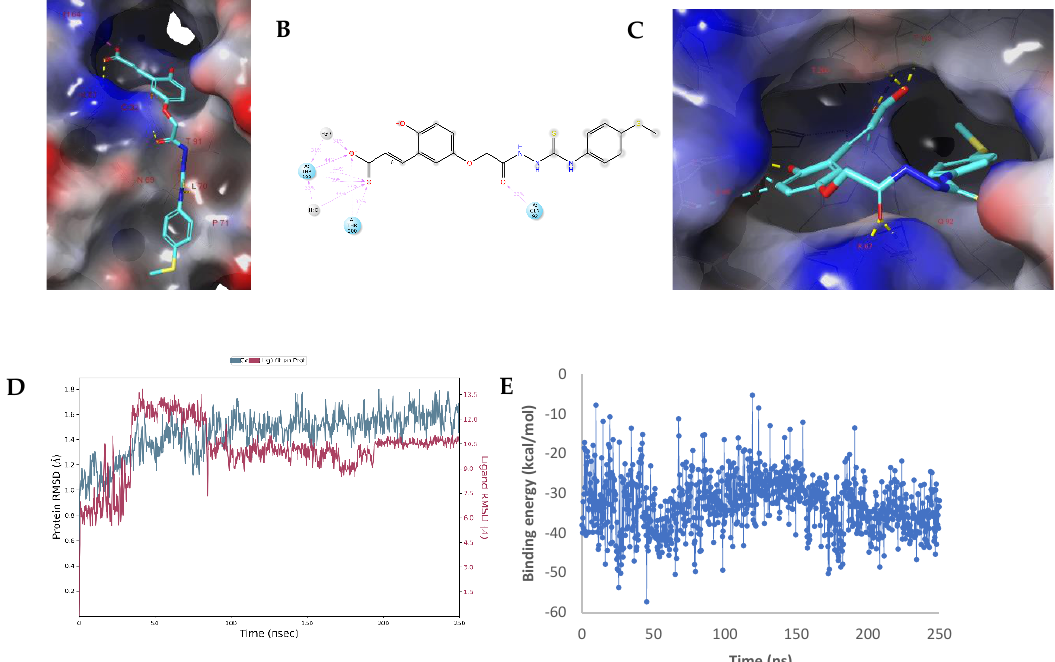
Figure 4. Molecular modelling results of the hCA XII– 22a-( E )-open interaction. ( A ) Docked pose of 22a-( E )-open . ( B ) The ligand–protein binding interactions observed for 30% or more of the duration of the unrestricted MD simulation. ( C ) Ligand pose after a 250 MD simulation. ( D ) RMSD value of the protein C α -atoms and the ligand heavy atoms. ( E ) Binding energy. In the 2D plots, anionic residues are indicated in red, cationic residues are indicated in purple, hydrophobic residues and surfaces are indicated in green and hydrophilic residues and surfaces are indicated in light blue. Hydrogen bonds are indicated in purple (2D plots) or yellow ( A , C ) dashed lines.